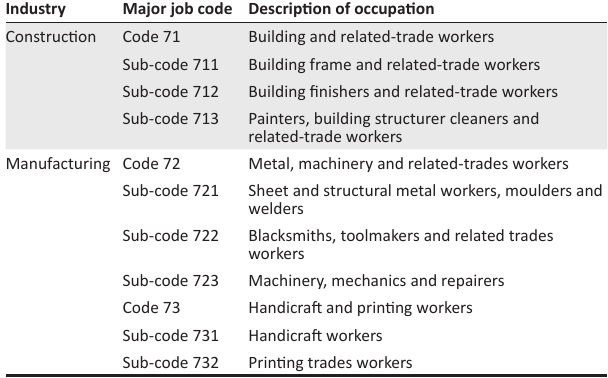
TABLE 1: Different International Standard Classification of Occupations-88 major job